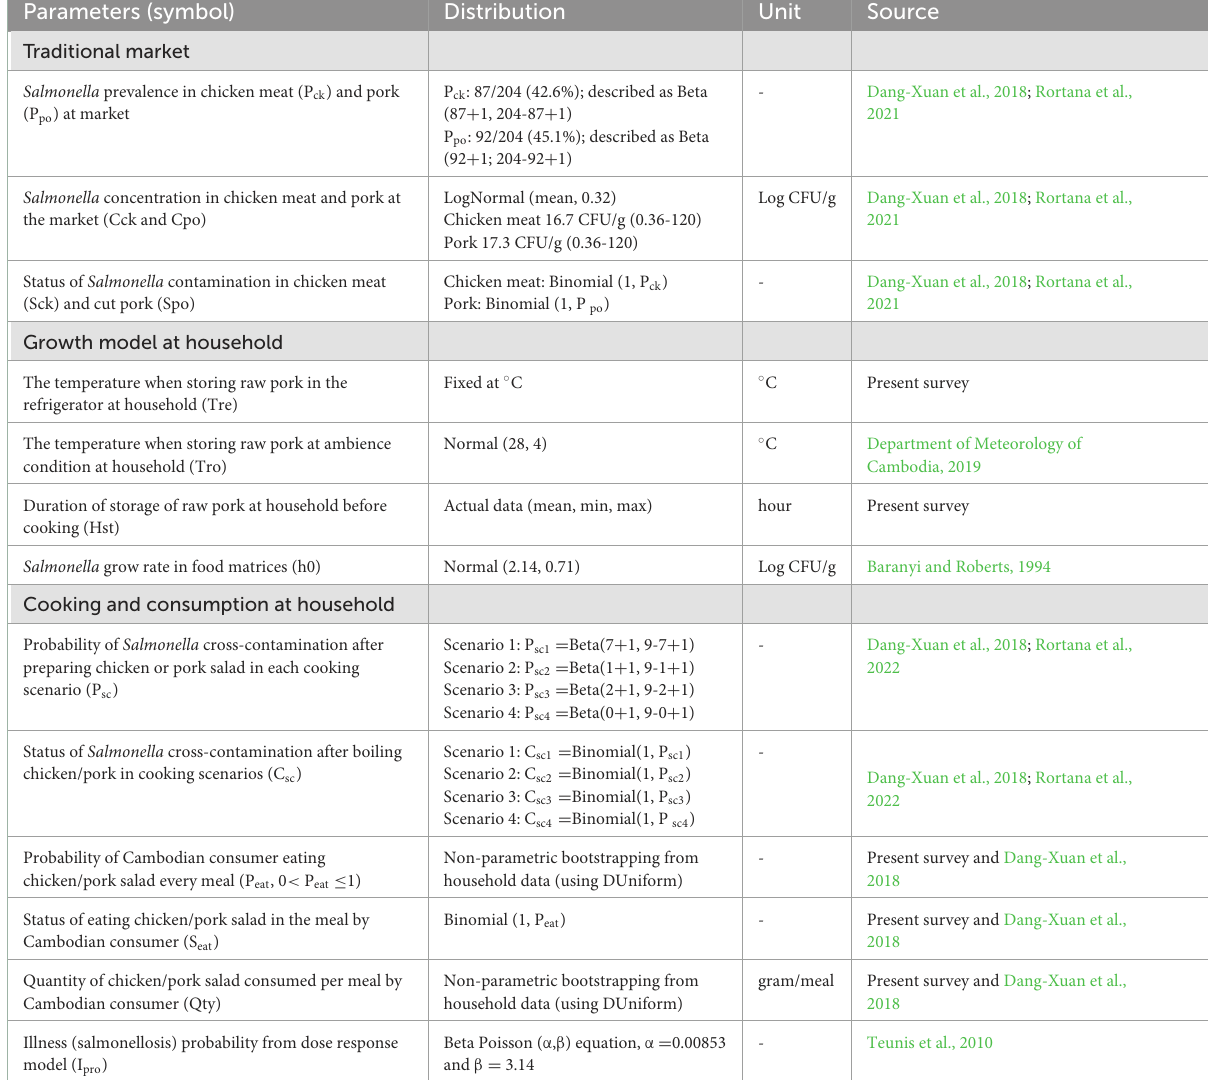
TABLE 2 Summary of the parameters, statistics, distribution, and data sources used in the QMRA model to estimate the risk of salmonellosis through chicken and pork salad consumption in Cambodia. Parameters